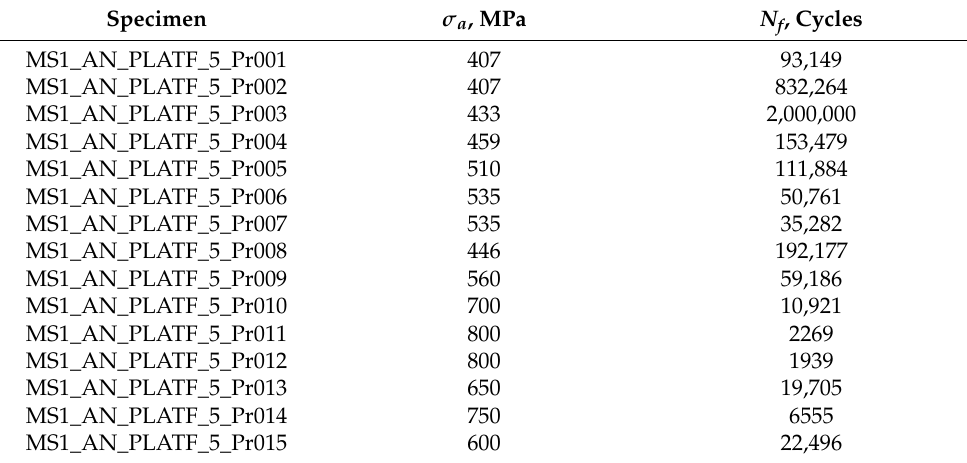
Table 2. Fatigue test results under tension–compression loading and R = −